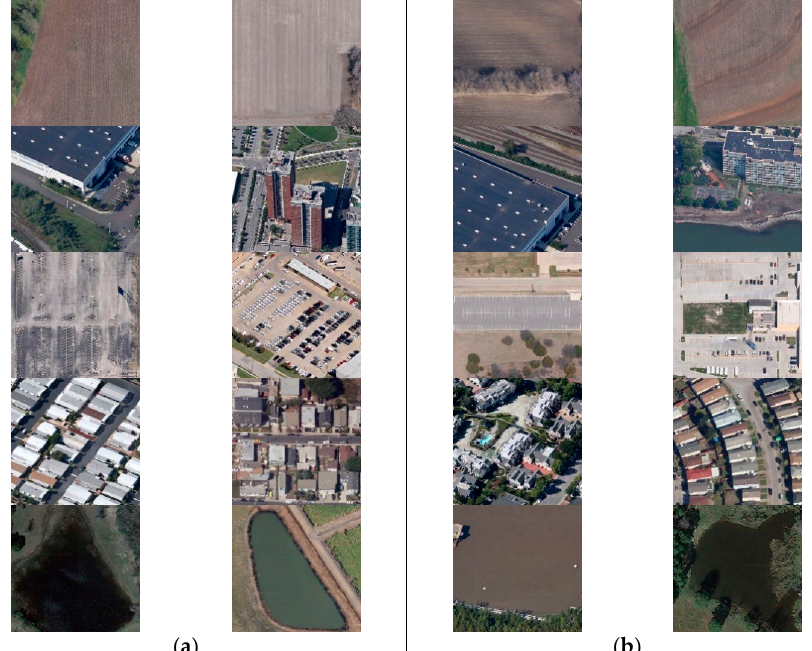
Figure 15. Some of the classification results of SGNAS and other models in the cross-domain scene dataset of SIRI-WHU → RSSCN7. The first, second, third, fourth, and fifth rows correspond to the scene classes of farmland, industrial region, parking lot, residential region, and river and lake in the RSSCN7 dataset, respectively. ( a ) Correctly classified images for all the models. ( b ) Images classified correctly by SGNAS, but incorrectly classified by other models were used for comparison.